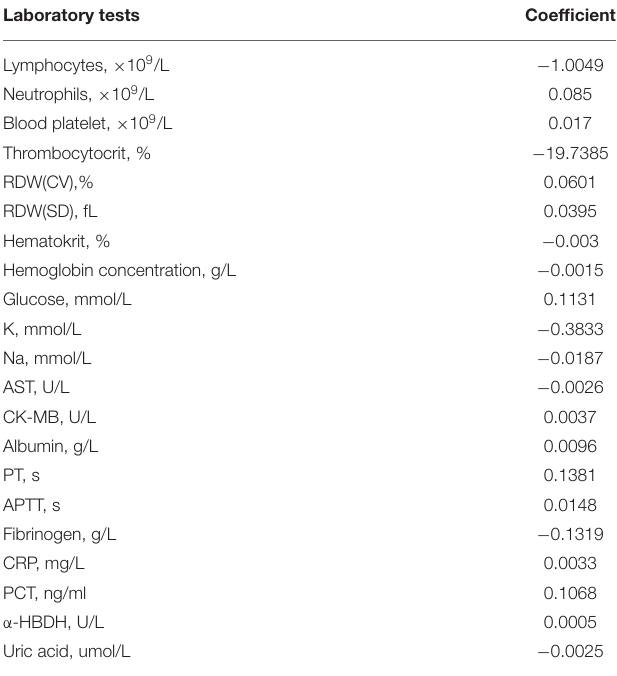
TABLE 2 | Coefficients of LASSO logistic regression model for predicting development of critical illness in 1,064 patients hospitalized with COVID-19 in the development